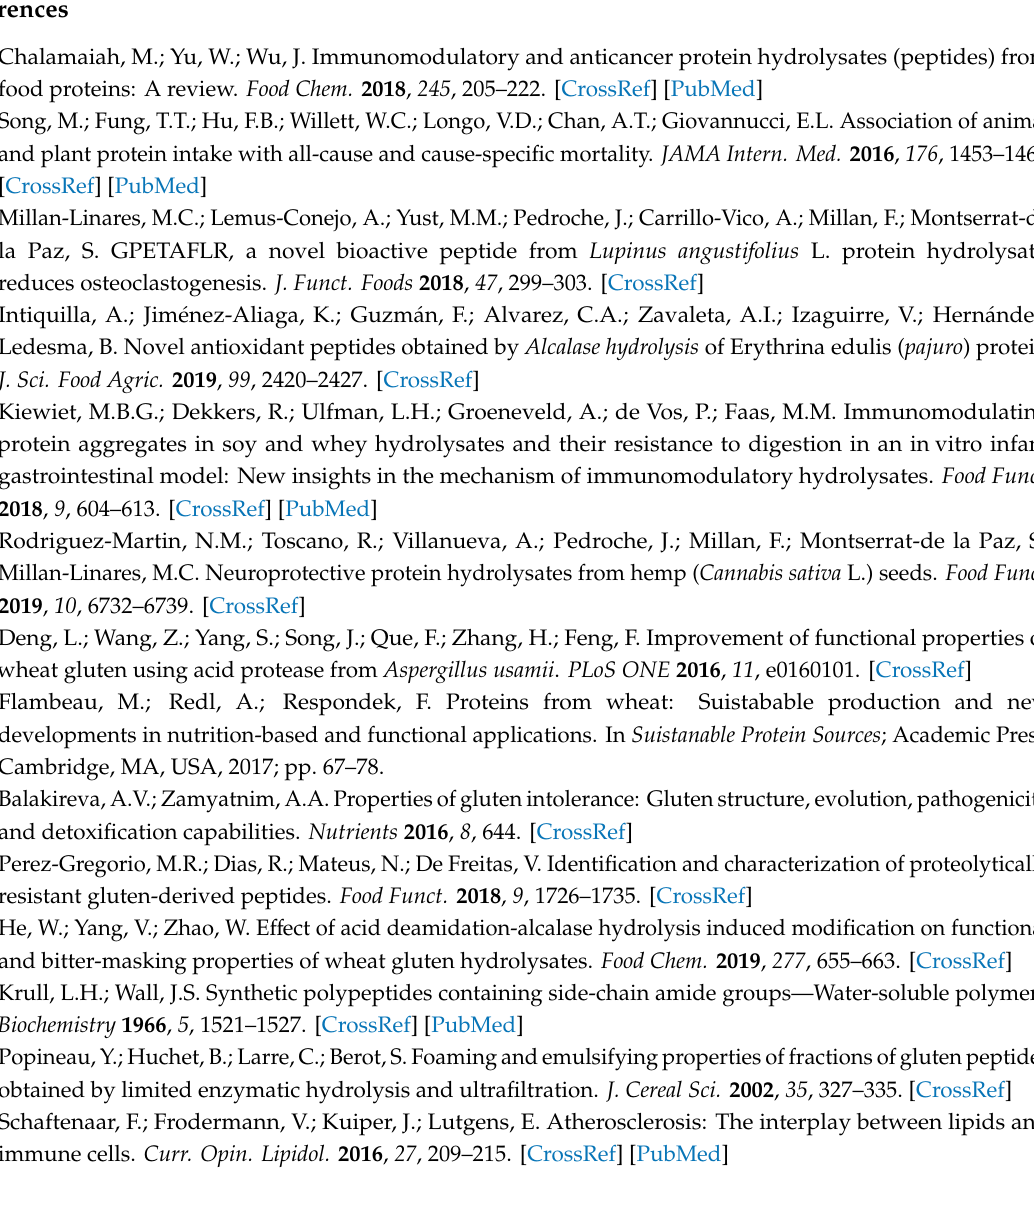
Table S1: Chemical composition of WGPC. Values, presented as percentage in dry basis, are mean ± standard deviation of triplicates, Table S2: Amino acid composition of WGPC. Values, presented as percentage of amino acids on total amino acid content, are mean ± standard deviation of triplicates, Table S3: Sequence and GenBank accession number of oligonucleotides used in